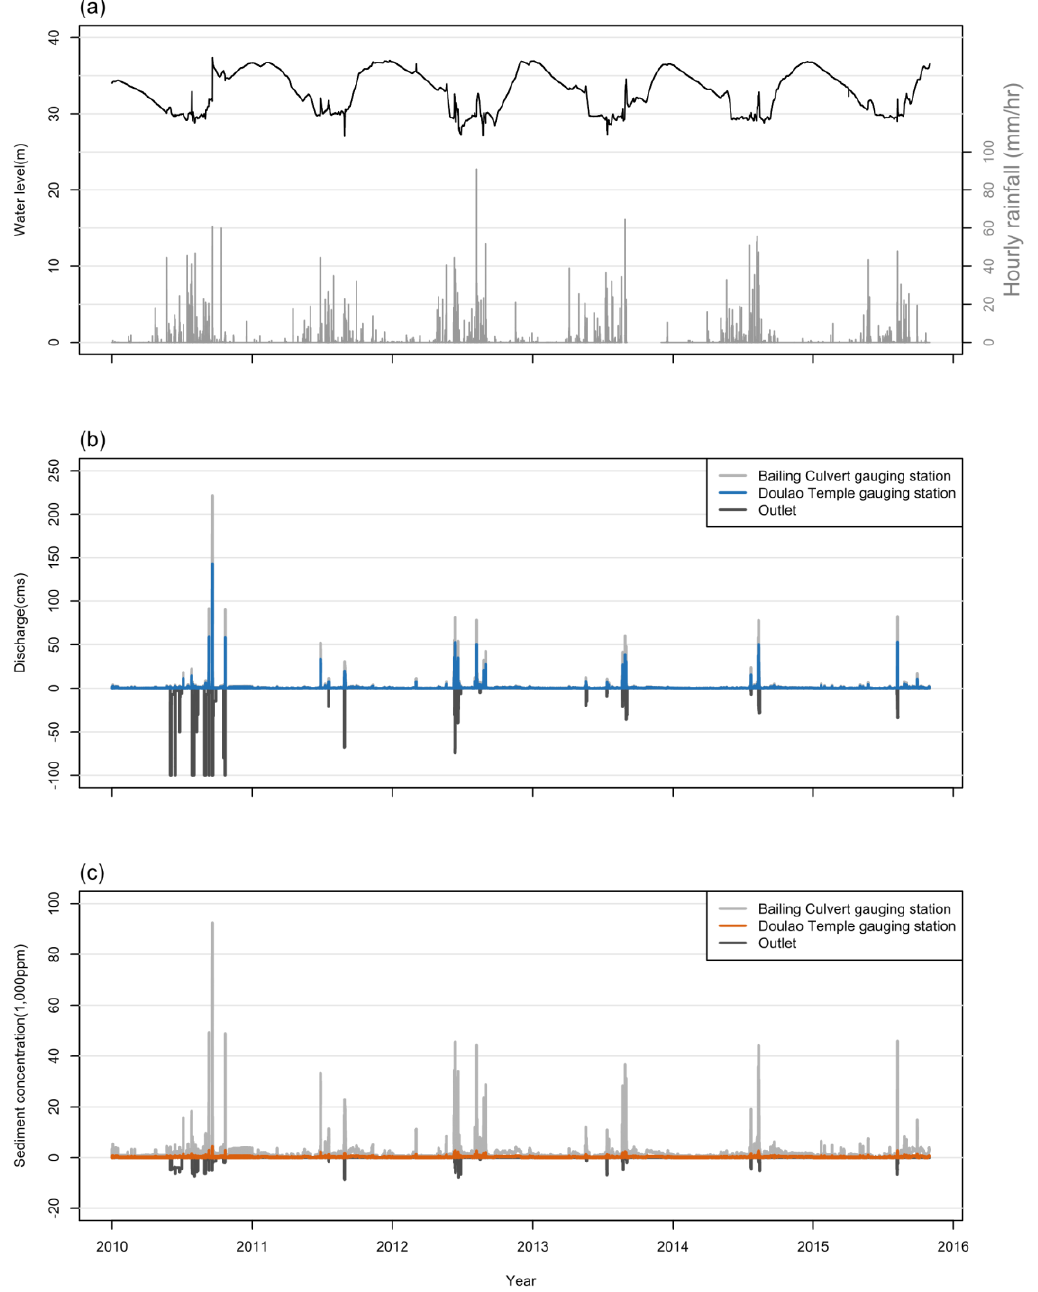
Figure 3. Hydrograph of ( a ) the water surface level of the Agongdian watershed and rainfall intensity; ( b ) the discharge; ( c ) the sediment concentration of the inflow from Doulou and Bailing gauging stations and the outflow from Agongdian Reservoir. Doulou and Bailing stations represent Wanglai (north) and Zhuoshui (south) tributaries of Agongdian Reservoir.